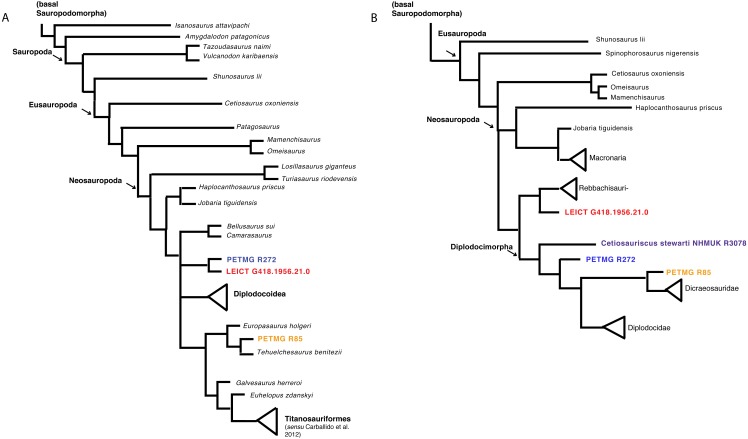
Phylogenetic analyses.Strict consensus tree based on Carballido et al. (2017) (A) and second analysis based on Tschopp & Mateus (2017) (B) with revised Cetiosauriscus (purple) coding, and additionally PETMG R85 (orange) PETMG R272 (blue) and LEICT G.418.1956.21.0 (red) as OTU’s.